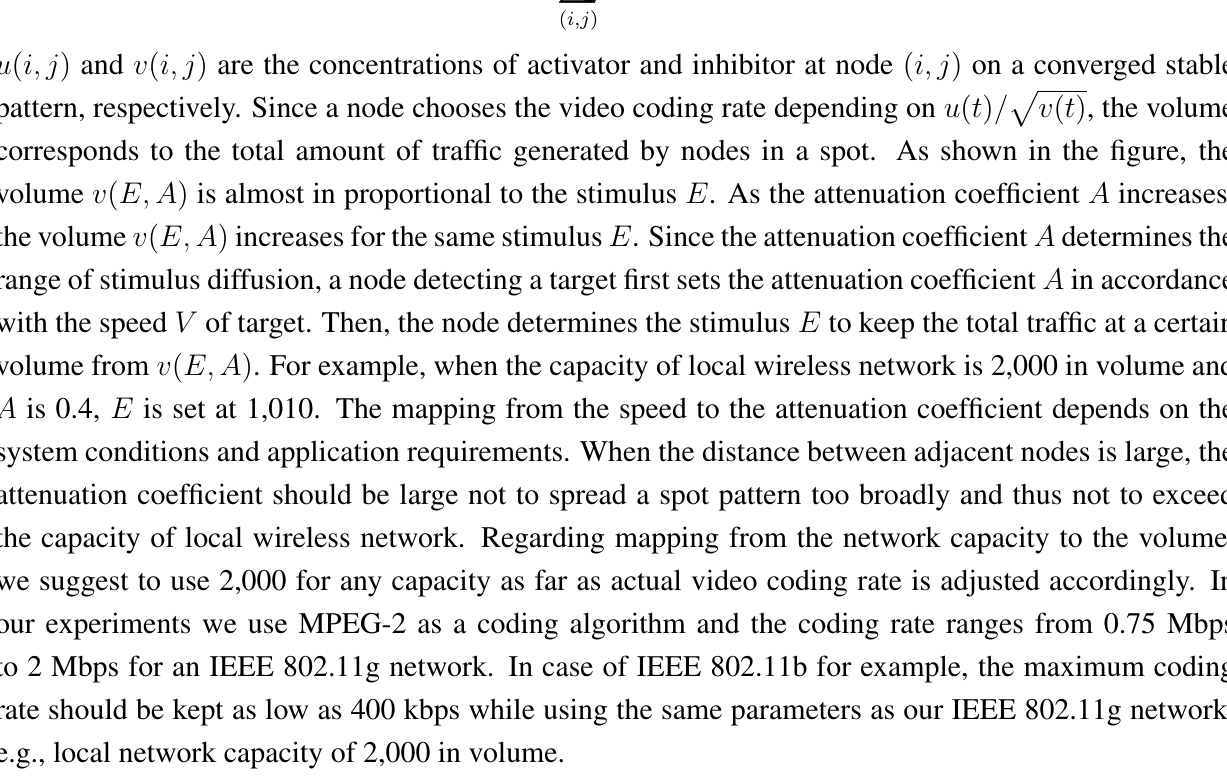
Figure 5 . Relationship among A , E , volume of